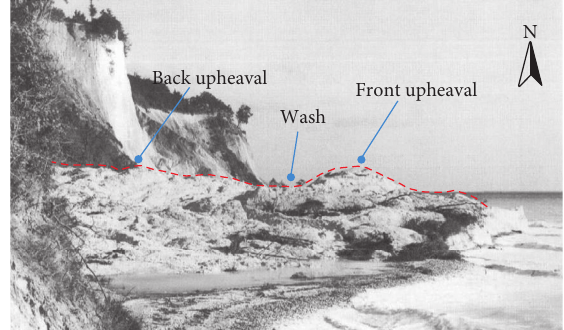
Figure 12: Flowslide occurred in May 1958 at Wissower Klinken, R¨ugen, Germany (54 ° 32 ′ 09 ″ N 13 ° 40 ′ 42 ″ E). Source from Hutchinson